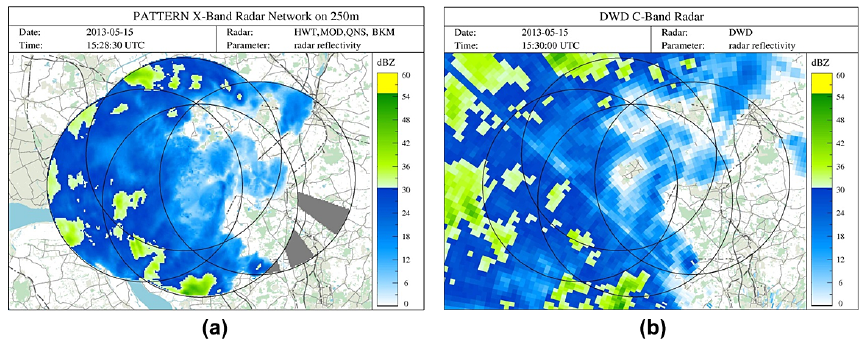
Figure 11. (a) Composite of reflectivity fields of all four network radars for 15 May 2013, 15:28:30UTC, and (b) reflectivity field from radar Hamburg for 15 May 2013, 15:30UTC.